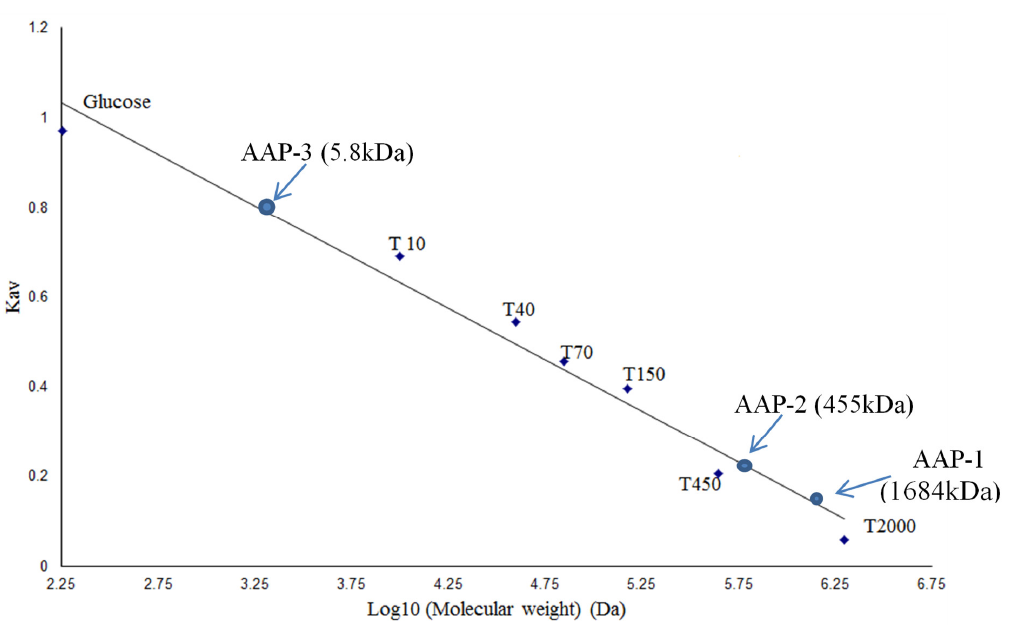
Figure 3. Calibration curve for the determination of molecular weights of polysaccharides from A. annua based on the elution volume and the molecular mass of standard dextran series of T2000 (2000 kDa), T450 (450 kDa), T150 (150 kDa), T70 (70 kDa), T40 (40 kDa), T10 (10 kDa) and glucose (180 Da) (Note: Kav = (V e − V o )/(V t − V o ), V o is void volume, V t is total volume and V e is elution volume).